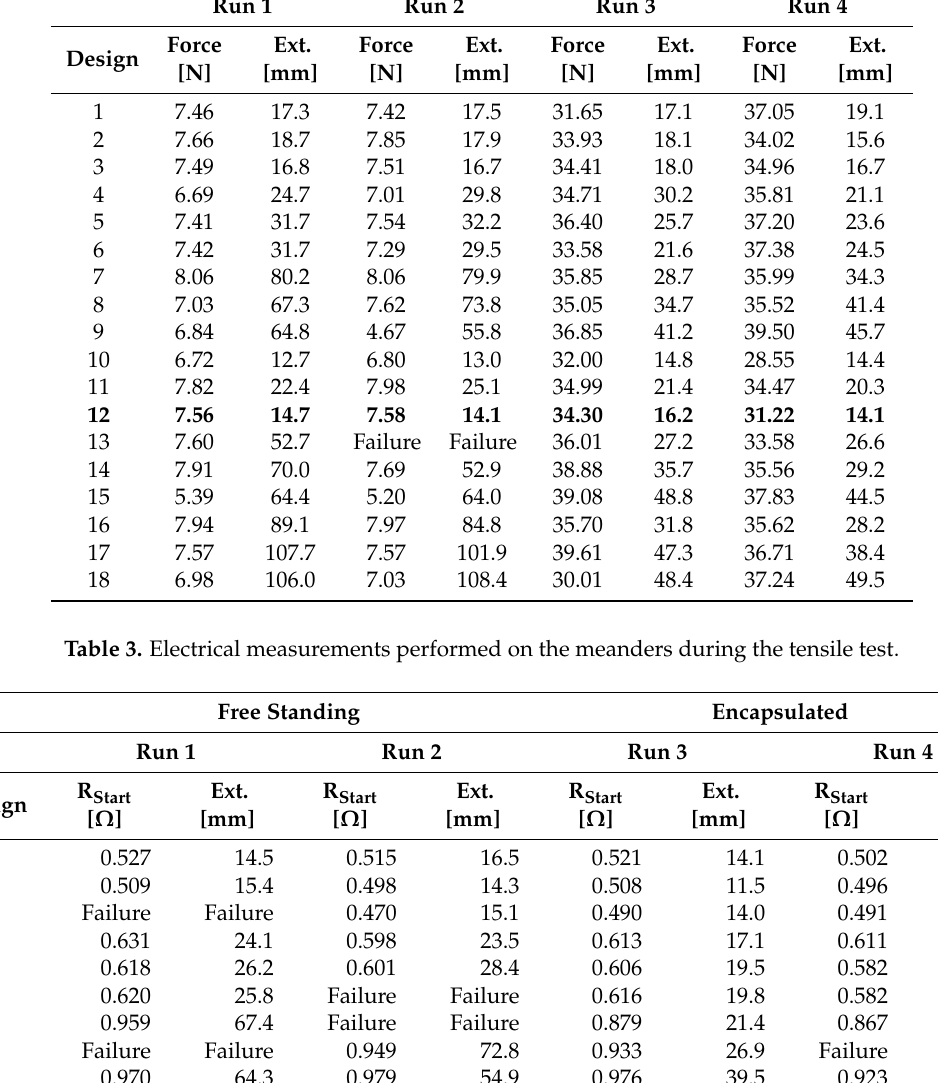
Table 2. Mechanical measurements performed on meanders using a tensile tester.